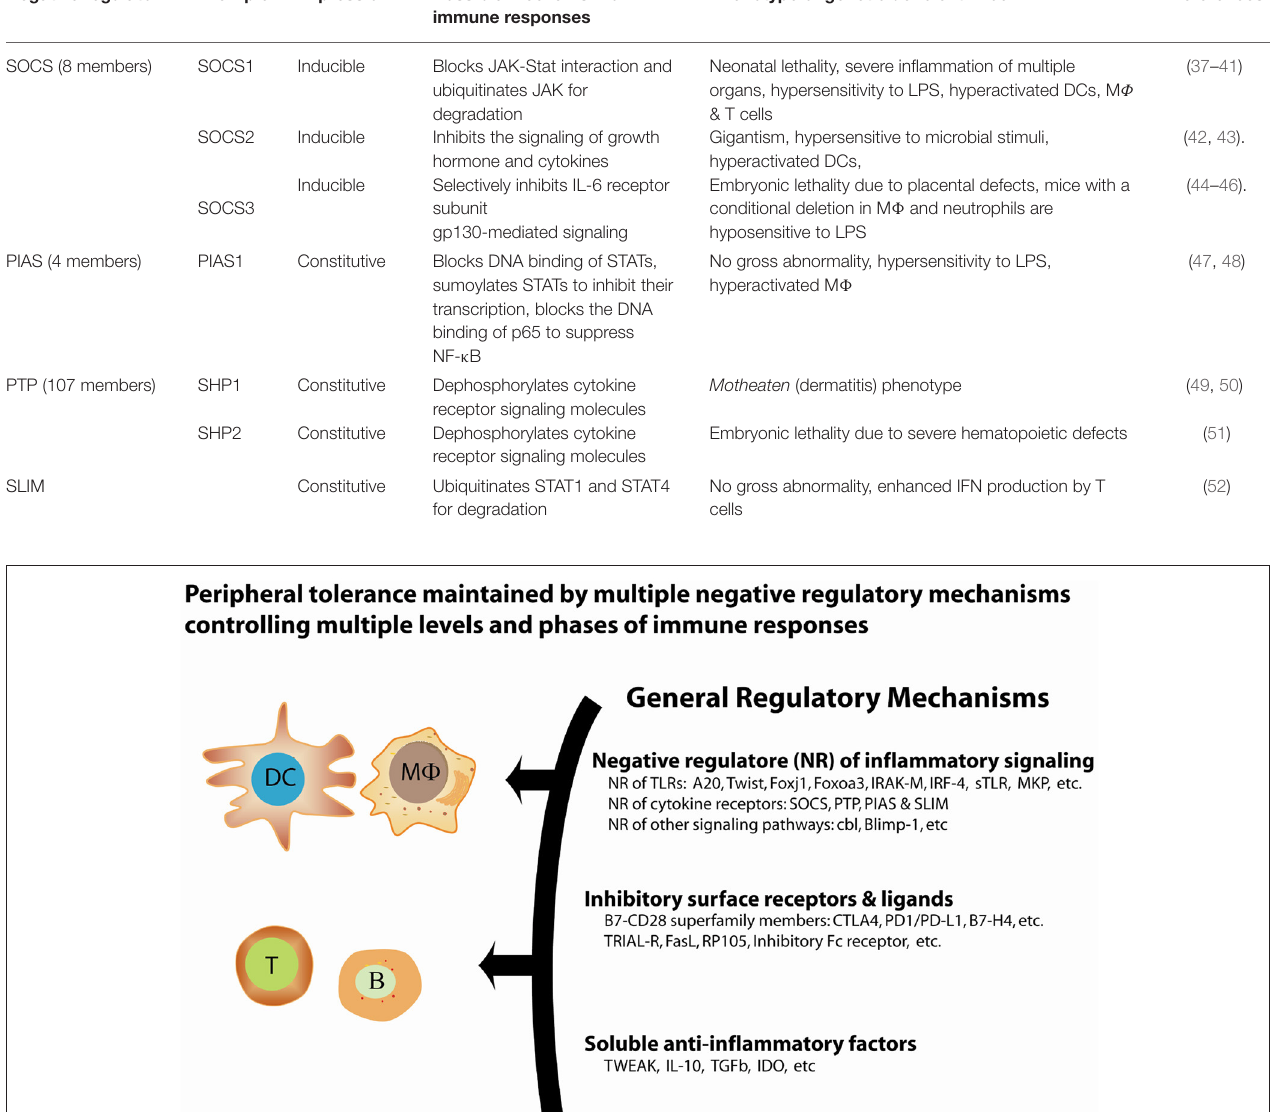
TABLE 2 | Representative negative regulators of cytokine receptor signaling pathways. Negative regulator